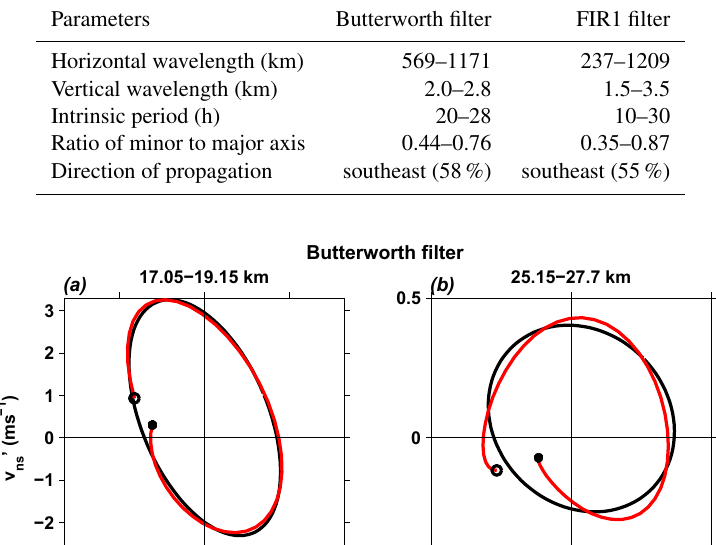
shows a sharp cutoff and also requires a much lower filter order than the corresponding FIR1 filter. A few hodographs plotted with horizontal wind perturbations using both the fil- ters are displayed in Fig. 4a–d. North is denoted by 0 ◦ in the hodographs, and its orientation angle increases clock- wise. Clockwise rotation of the hodograph indicates upward energy propagation in the Northern Hemisphere. The IGW parameters derived from these hodographs are listed in Ta- ble 1. The ranges of horizontal wavelength, vertical wave- length and intrinsic period are broader using an FIR1 filter compared to those obtained using a Butterworth